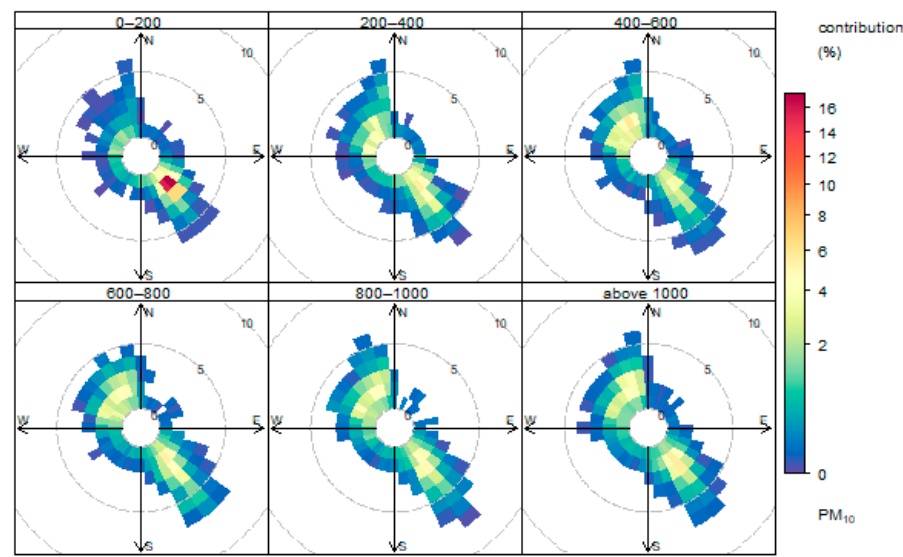
Figure 16. PM 10 weighted concentration rose divided according to the mixing layer height (in m), the Tˇrinec-Kosmos site, 2016–2019.